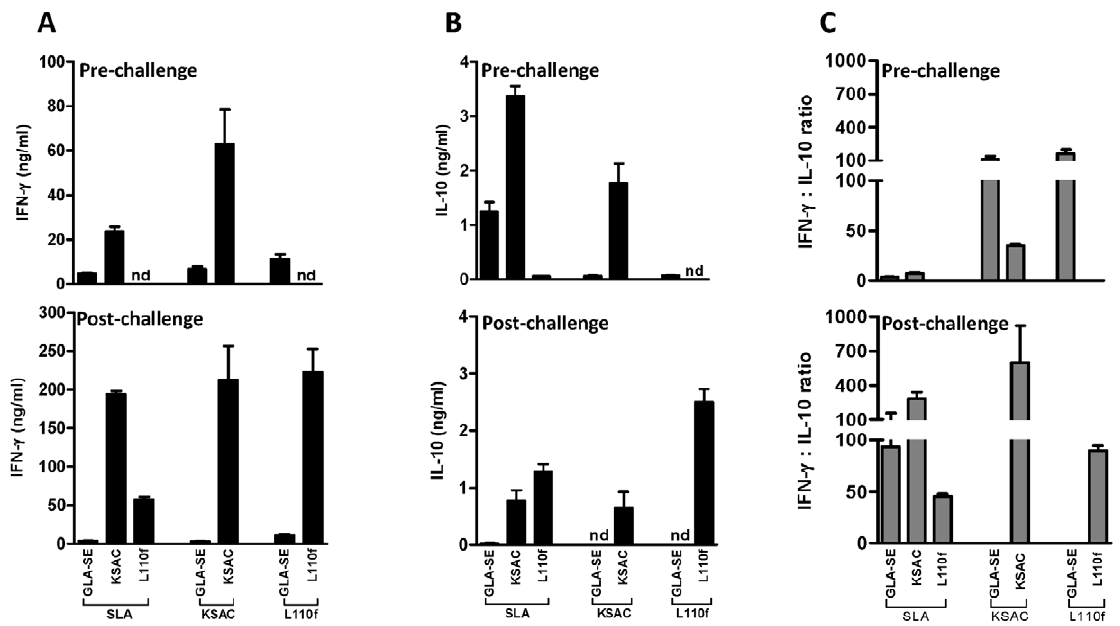
Figure 4. Cytokine production before and after challenge of mice with L. major -infected sand flies. Mice were vaccinated subcutaneously with 10 m g KSAC + 20 m g GLA-SE, 10 m g L110f + 20 m g GLA-SE, or 20 m g GLA-SE alone. IFN- c (A) or IL-10 (B) production was measured by ELISA after in vitro stimulation of spleen cells with 100 m g SLA, 10 m g recombinant KSAC, or 10 m g recombinant L110f. Results are from stimulations performed at two time points: three weeks after the last immunization and one week post challenge. (C) Ratio of IFN- c : IL-10 in vaccinated mice. Mean and SEM of three mice per group. Data are representative of two independent experiments. nd=none detected.